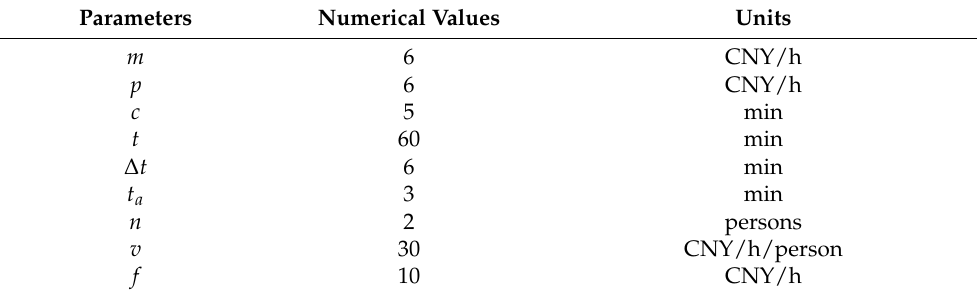
Table 3. Survey Data Sheet.